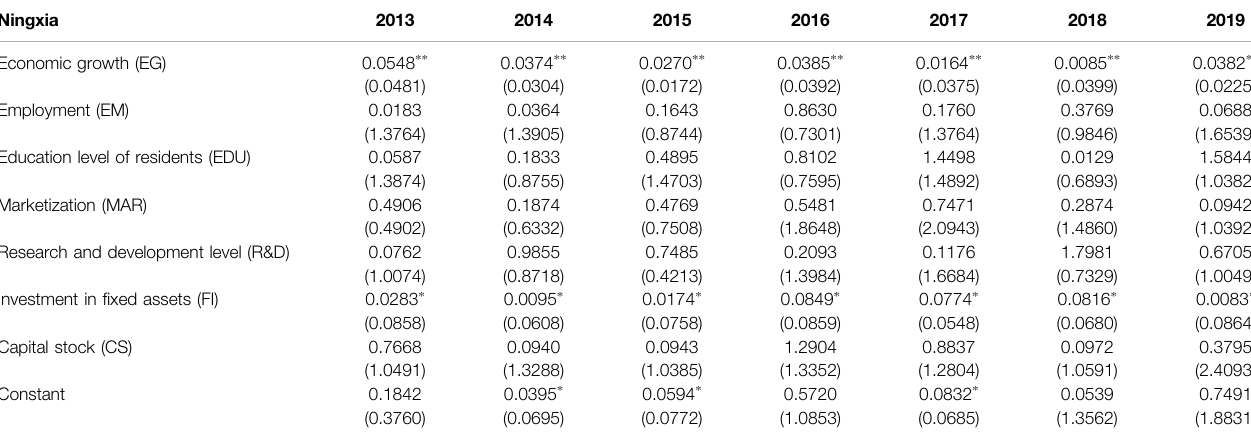
TABLE 17 | Driving force of Ningxia health tourism industry convergence.